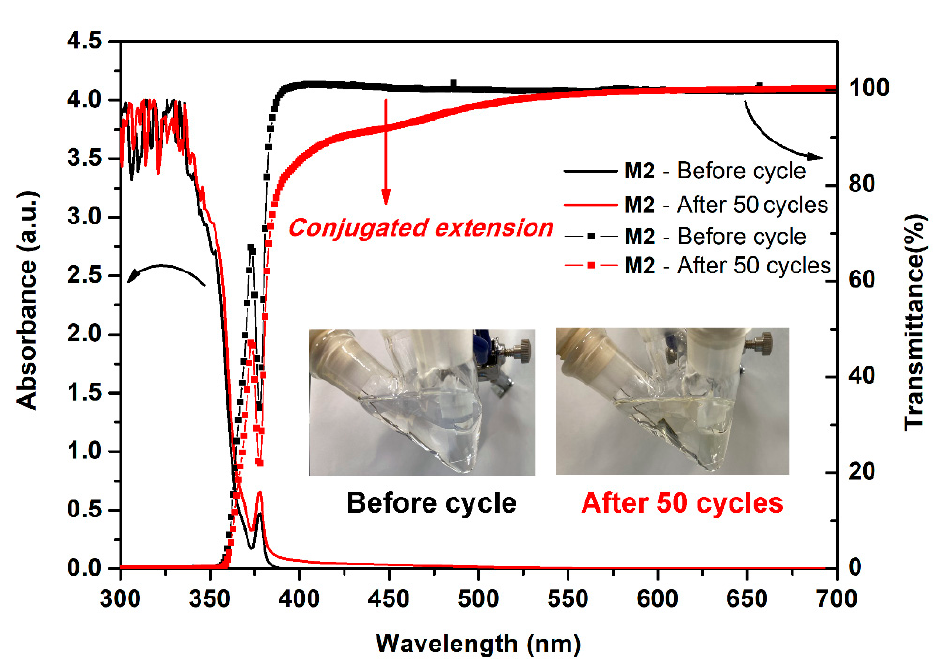
Figure 11. Absorption, transmittance spectra and inset images of the 500 µ M model compound M2 in 0.1 M Bu 4 NClO 4 /CH 2 Cl 2 before and after continuous 50 cycles of CV test at a scan rate of 50 mV/s.